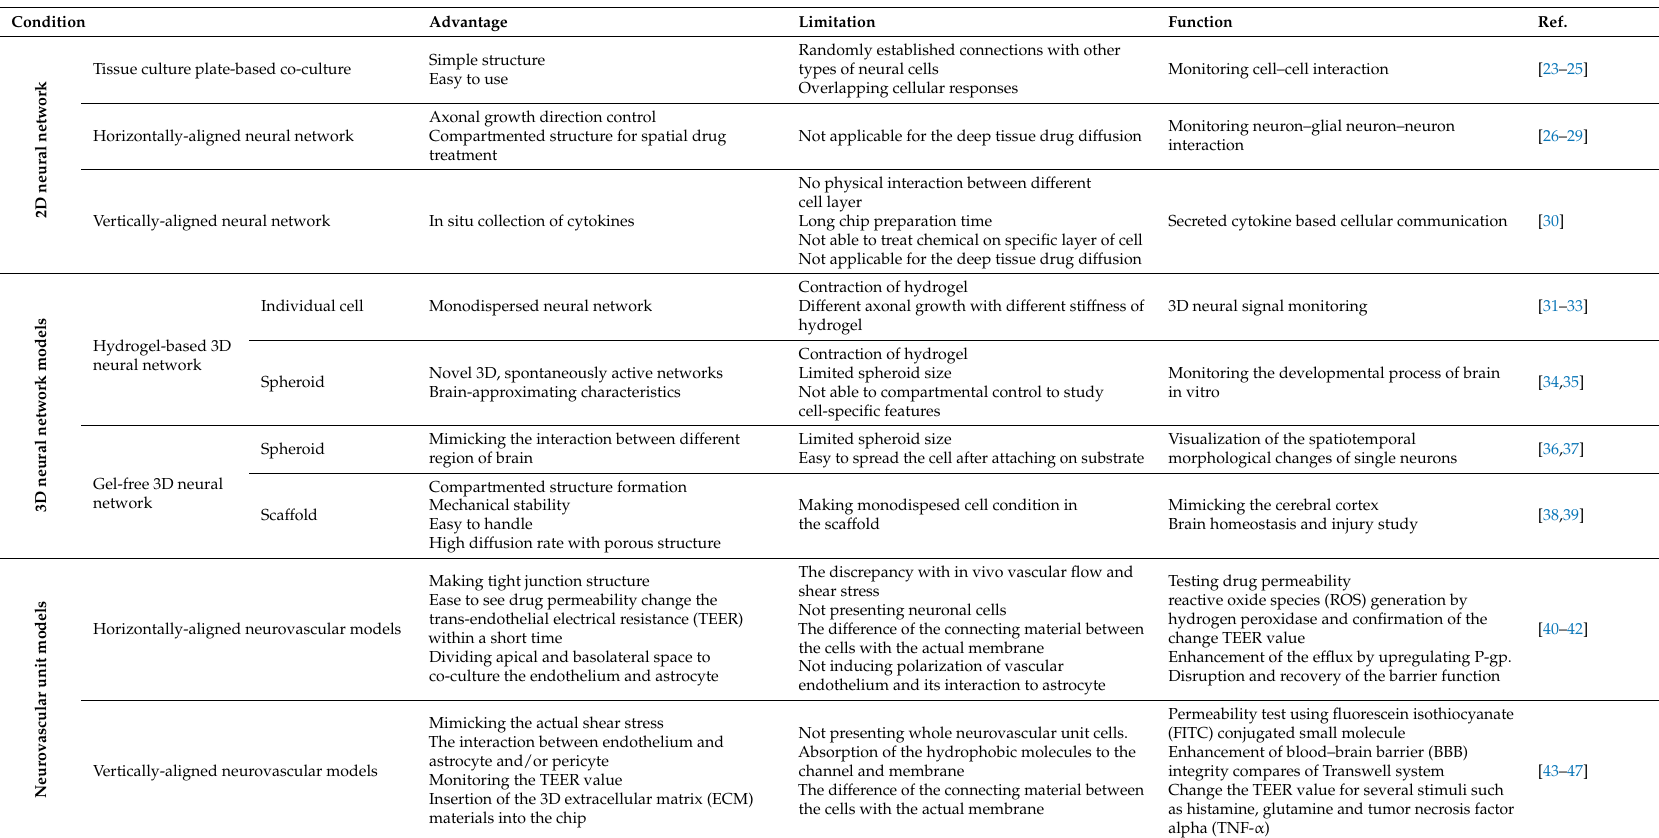
Table 1. Advantages and limitations of current central nervous system model on a